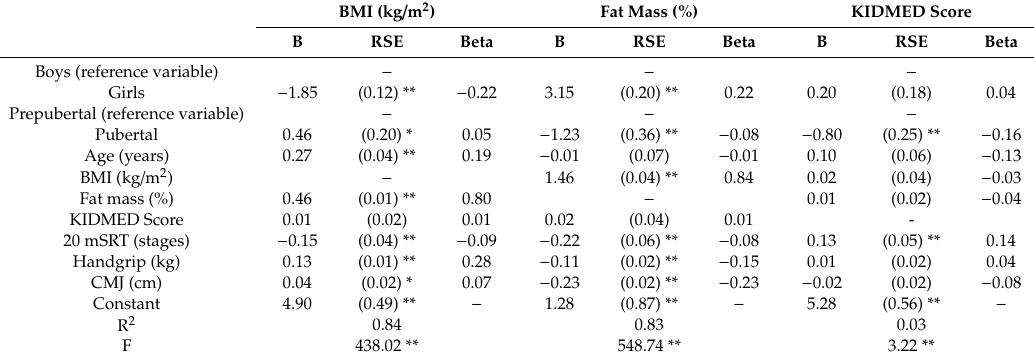
Table 3. Regression models for BMI fat mass, and KIDMED